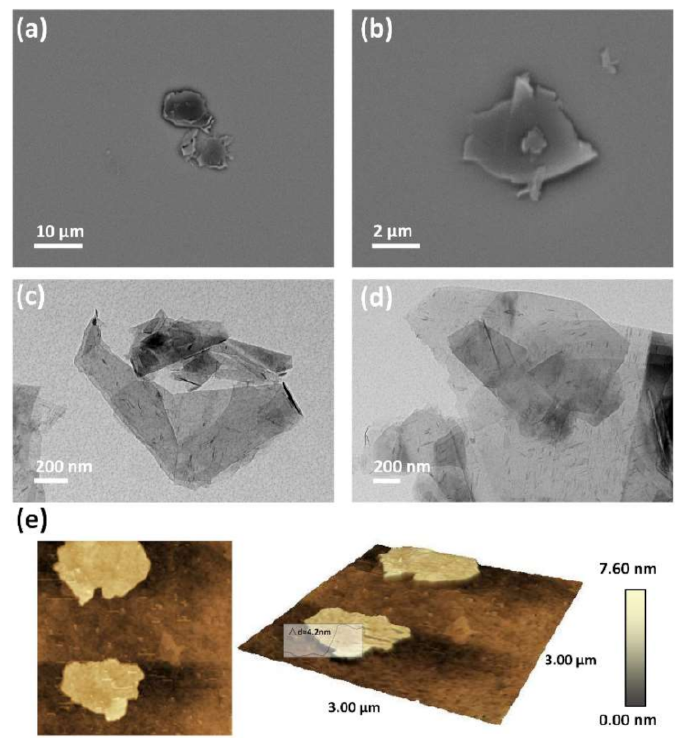
Figure 2. Morphology characterization of MLGPs. ( a , b ) SEM images at different scales; ( c , d ) TEM images at different scales; ( e ) AFM